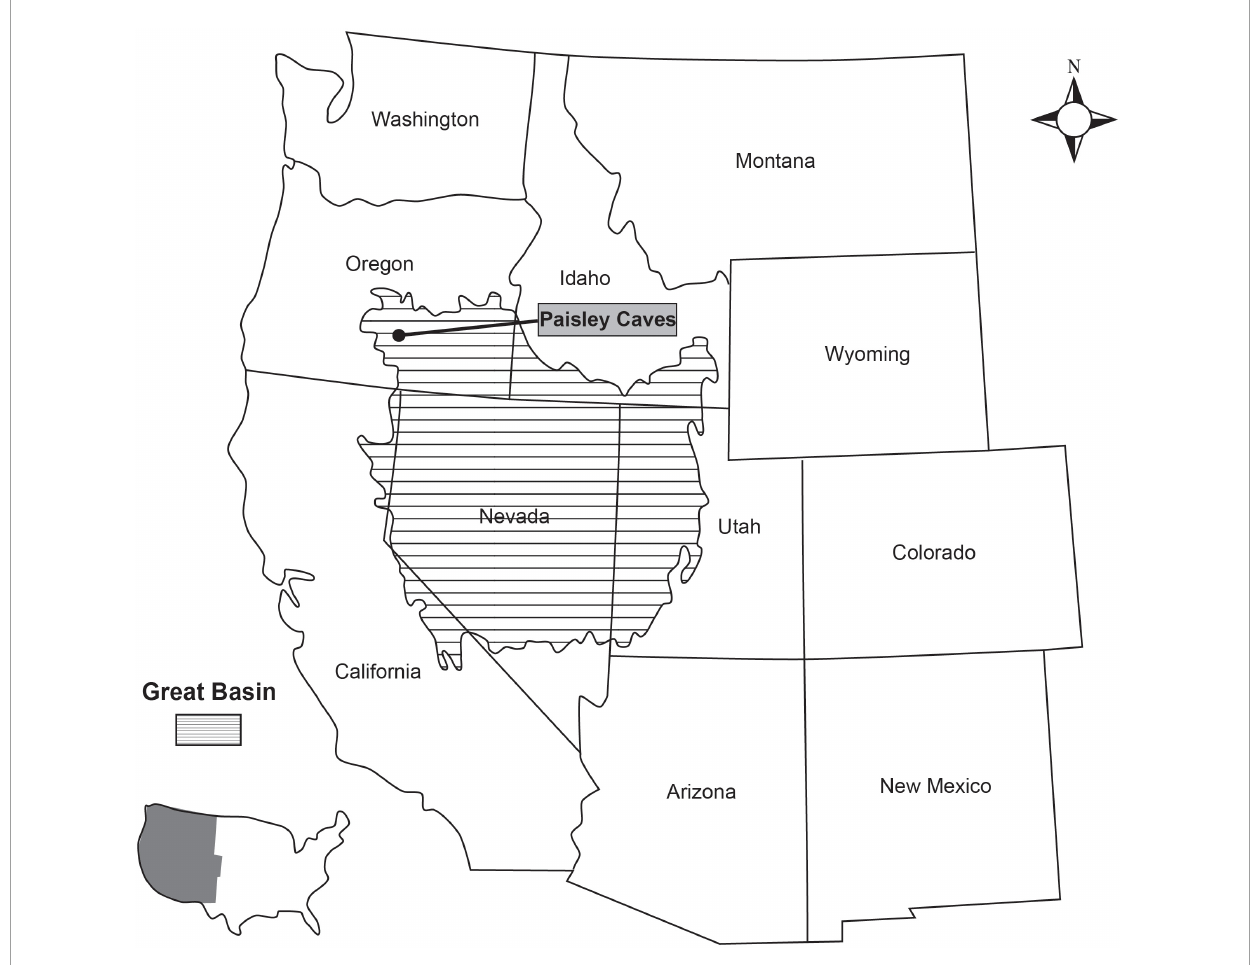
FIGURE1 Map showing the location of the Paisley Caves, Oregon, United